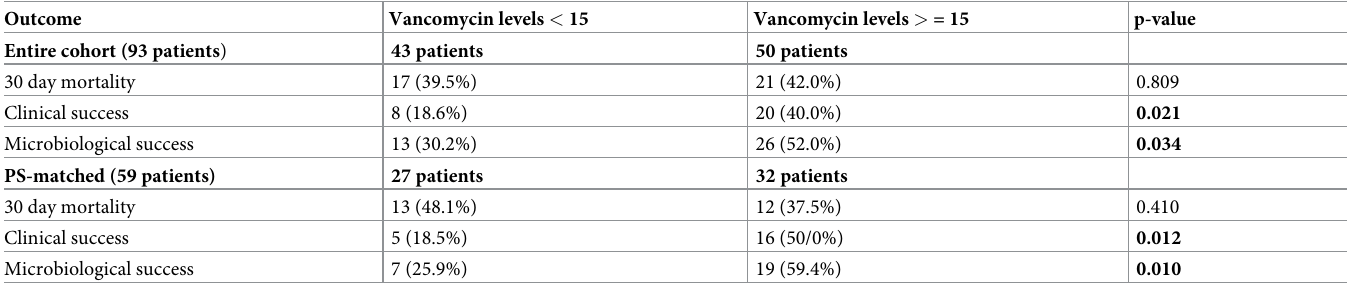
Table 2. Outcomes among patients with pneumonia according to vancomycin